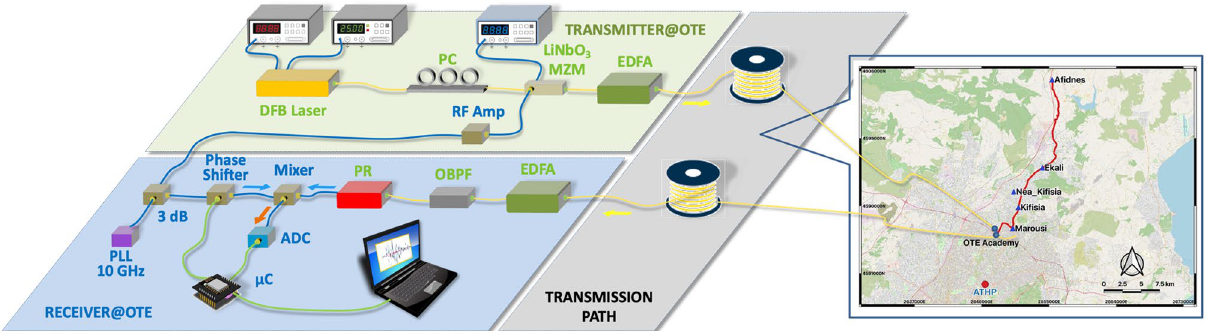
Figure 1. The experimental setup/conceptual scheme of MFFI: The experimental testbed was installed at OTE Academy. The transmitter consists of a distributed feedback (DFB) laser followed by a polarization controller and a Mach–Zehnder modulator of 10 GHz bandwidth, driven by a 10 GHz tone. An erbium doped fiber amplifier (EDFA) is used to boost the transmitted power. Light propagates from OTE Academy following the path to Marousi–Kifisia–Nea Kifisia–Ekali–Afidnes and vice versa (closed loop) entering the receiver’s EDFA at OTE Academy after approximately 50 km of transmission which translate to 25 dB of losses due to inefficient connections along the link that were inserted in order to emulate a longer link (125 km). The received signal, after optical amplification and proper optical filtering with the use of an optical band-pass filter (OBPF) for the reduction of amplifier’s noise is photodetected and mixed with the transmitter’s signal in order to extract the phase noise attributed to optical transmission. The baseband signal of phase noise is digitized with the use of an analog to digital converter and processed by a computer (see methods). Fiber deformations due to seismic events are imprinted on the phase noise. The map has been created using open software QGIS ver 3.16LTR (https:// www. qgis. org/ en/ site/ index.